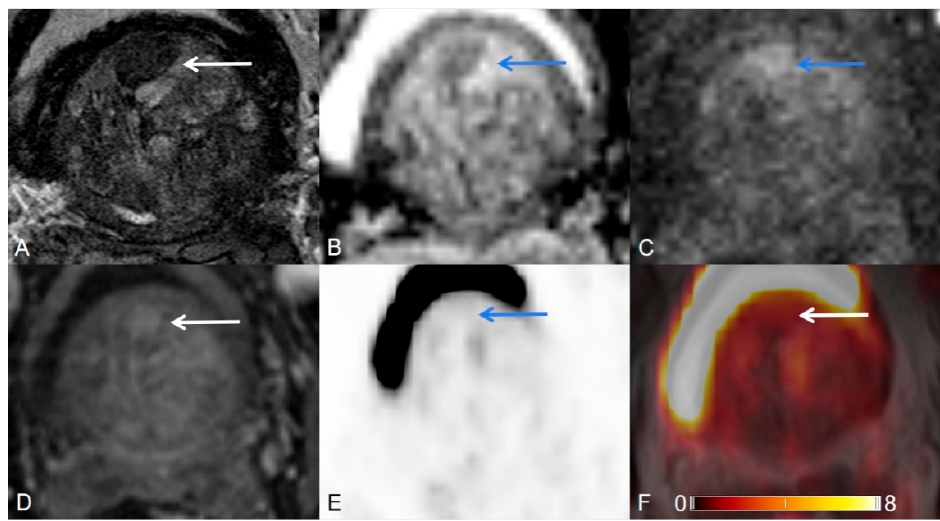
Figure 2. Transition zone with an atypical nodule. ( A ) Axial T2WI shows a homogeneous T2 hypointense, mostly encapsulated nodule. ( B ) ADC map image presents a focal lesion with a markedly hypointense signal below the background corresponding to the lesion seen in ( A ). ( C ) DWI (b = 1000 s/mm 2 ) shows a focal lesion with a markedly hyperintense signal above the background corresponding to the lesion seen in ( A , B ). ( D ) Early dynamic contrast-enhanced image presents avid enhancement within the nodule. T2WI = 2, DWI = 5, DCE = positive, PI-RADS assessment category = 3. ( E ) PET image shows no [ 68 Ga]Ga-PSMA-11 avid uptake. ( F ) [ 68 Ga]Ga-PSMA-11 PET/MRI fusion.